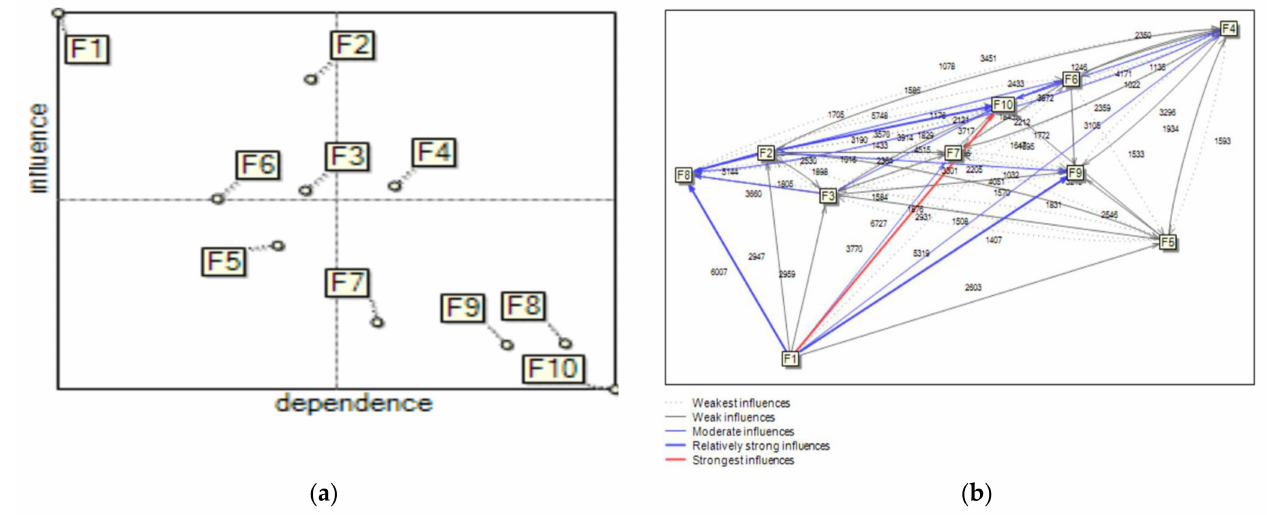
Figure 5. Indirect influence map ( a ) and graph ( b ) for SCFs with a defined power of